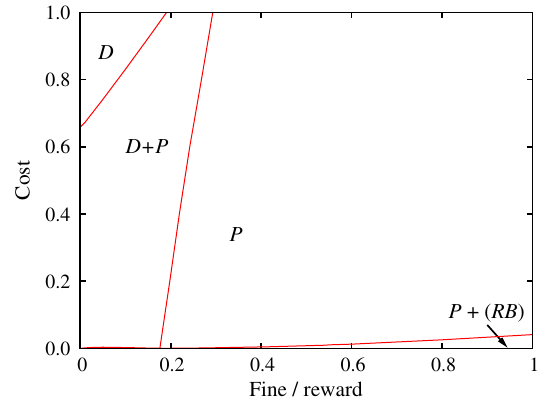
FIG. 1. Full (cid:1) (cid:1) (cid:2) phase diagram, as obtained for r ¼ 4 : 5 . Solid red lines denote continuous phase transitions. If defectors die out, strategies R and B become equivalent (see the main text for details), hence the ð RB Þ notation in the lower right corner of the parameter plane. The vertical resolution hides the intricate structure of the phase diagram for very low values of (cid:2) , which we therefore show separately in Fig.